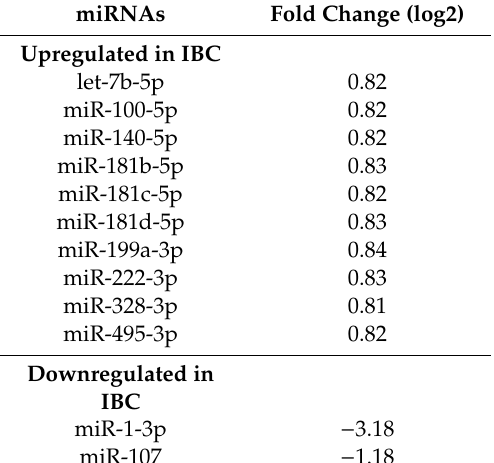
Table 2. Fold change of di ff erentially expressed (microRNAs) miRNAs in IBC compared to non-IBC. miRNAs Fold Change (log2)